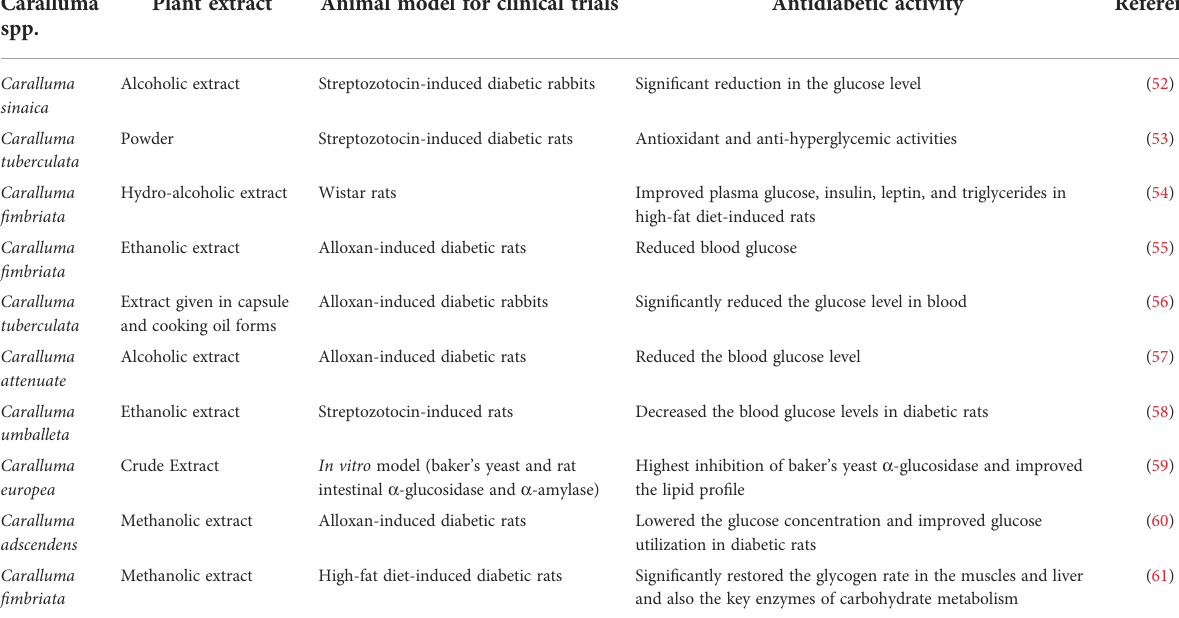
TABLE 2 Screening of Caralluma natural antidiabetic products using animal models. Caralluma spp.